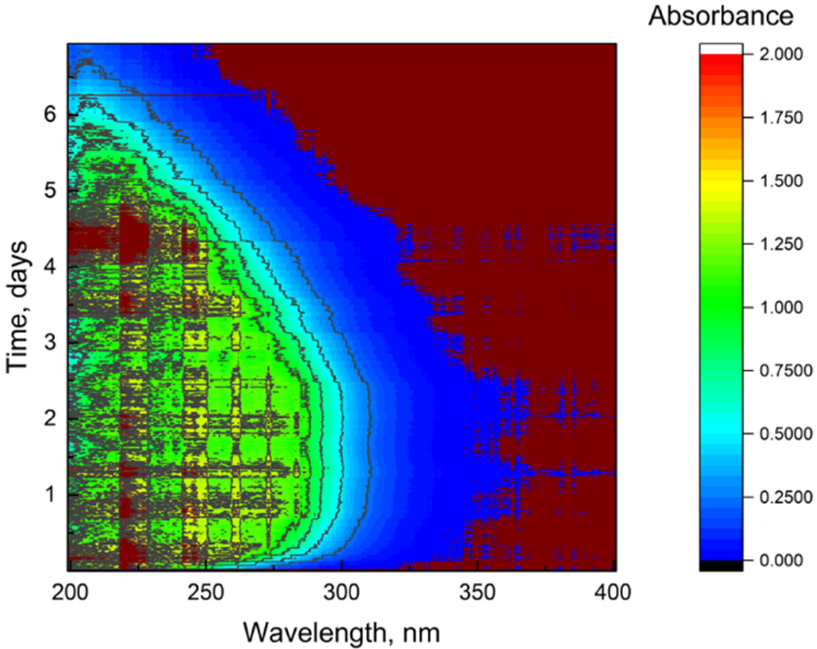
Figure 4. The profile of 1000 collected absorbance spectra from a fiber-optic probe of dialytic solution during the process, range 190–400 nm. The scanning pitch is 1 nm. The scan rate is 60 nm/min. More specific comments are presented in Table 1. Excess purification reagents (EDTA and H 2 O 2 ) were removed by dialysis by an ultrapure water supply after 3 days following the reagent-supply stage. Below we describe each step in more